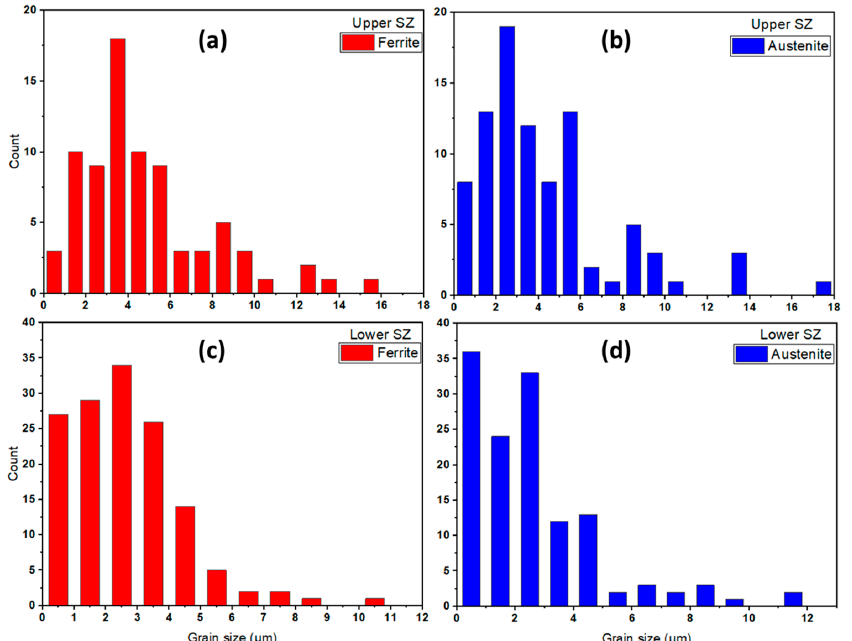
Figure 8. ( a ) Ferrite and ( b ) austenite grain size distribution histograms of upper zone, and ( c ) ferrite and ( d ) austenite grain size distribution histograms for 2205 DSS butt joint welded at 600 rpm, 50 mm/min, and 14 kN.